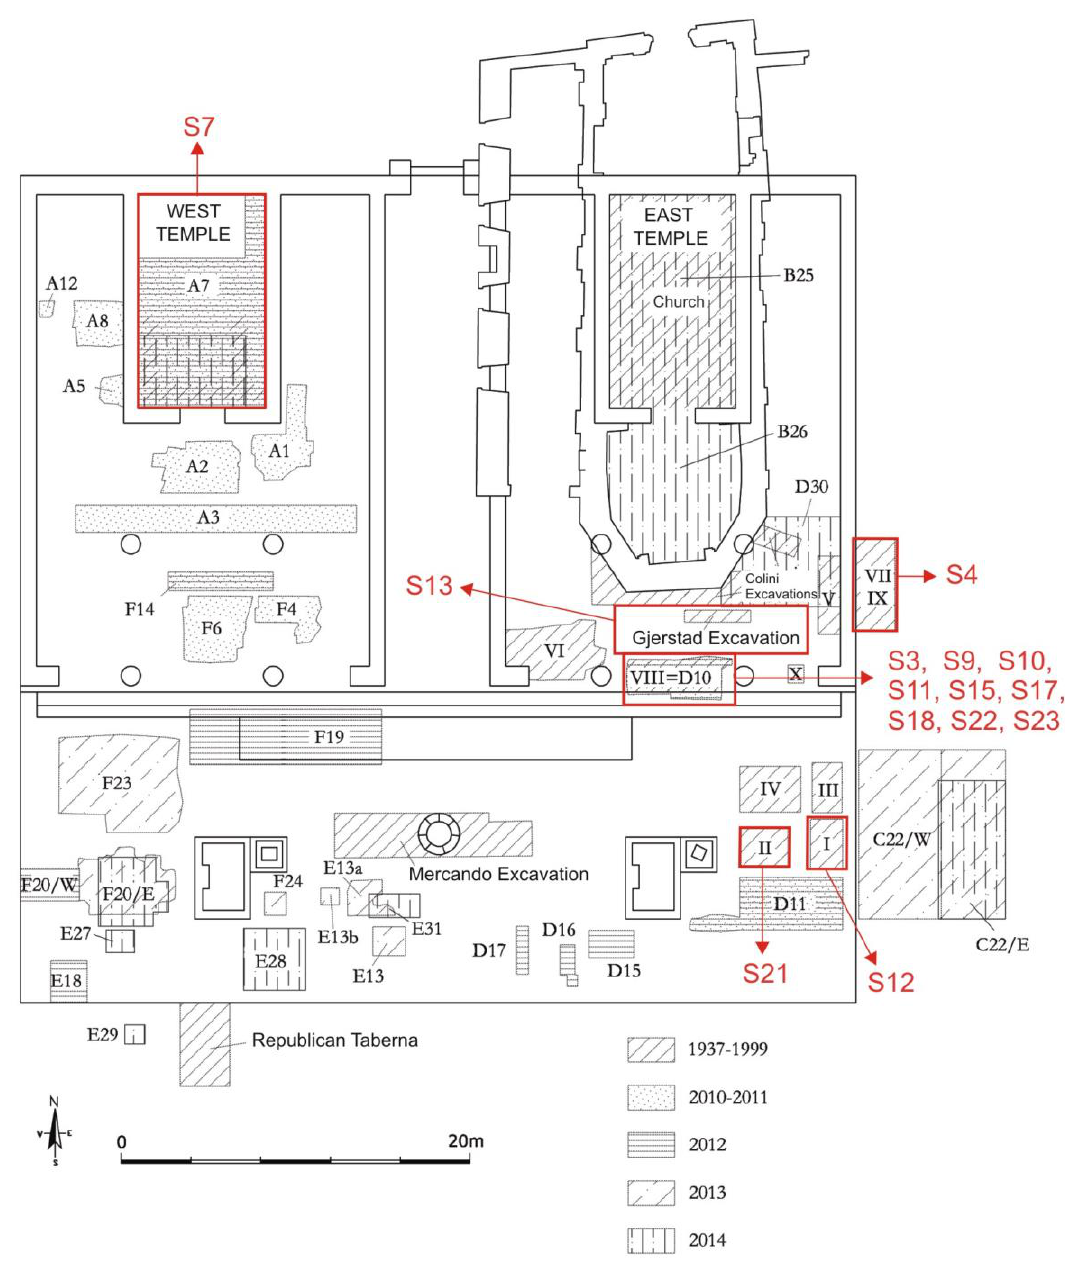
Figure 1. Map of the archaeological site of S. Omobono showing sample collection locations and the areas excavated from 1937 to 2014.